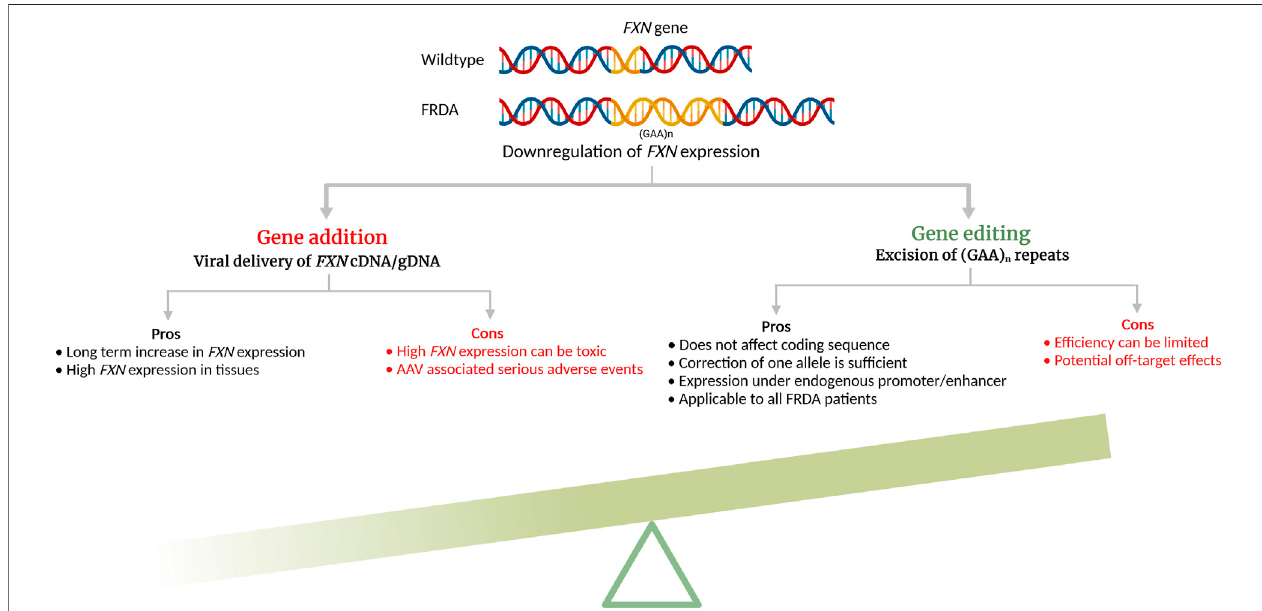
FIGURE 1 | Pros and cons of additive gene therapy and gene editing for Friedreich ’ s ataxia (cDNA — complimentary DNA; gDNA — genomic DNA). The schematic was created with BioRender.com.